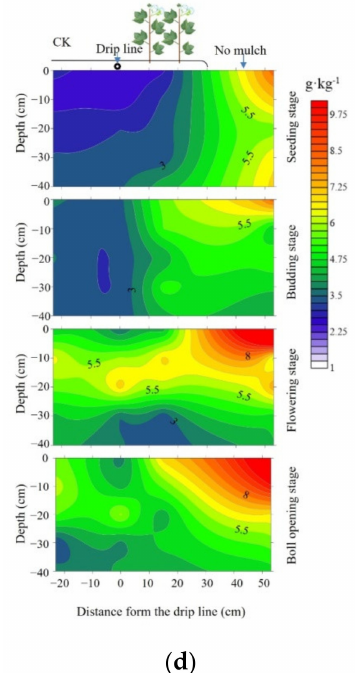
Figure 4. Dynamic changes of soil salinity content in 0–40 cm soil layer of each treatment. ( a ) irrigation application at the seeding stage; ( b ) irrigation application at the seeding stage + budding stage; ( c ) irrigation application at the seeding stage + budding stage + flowing stage; ( d ) no irrigation application